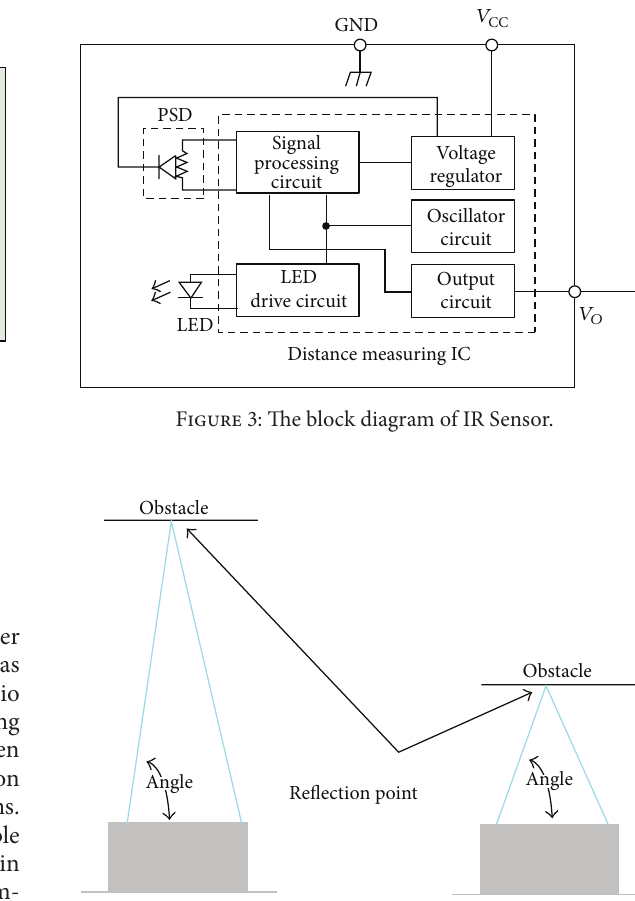
Figure 4: Different angles with different